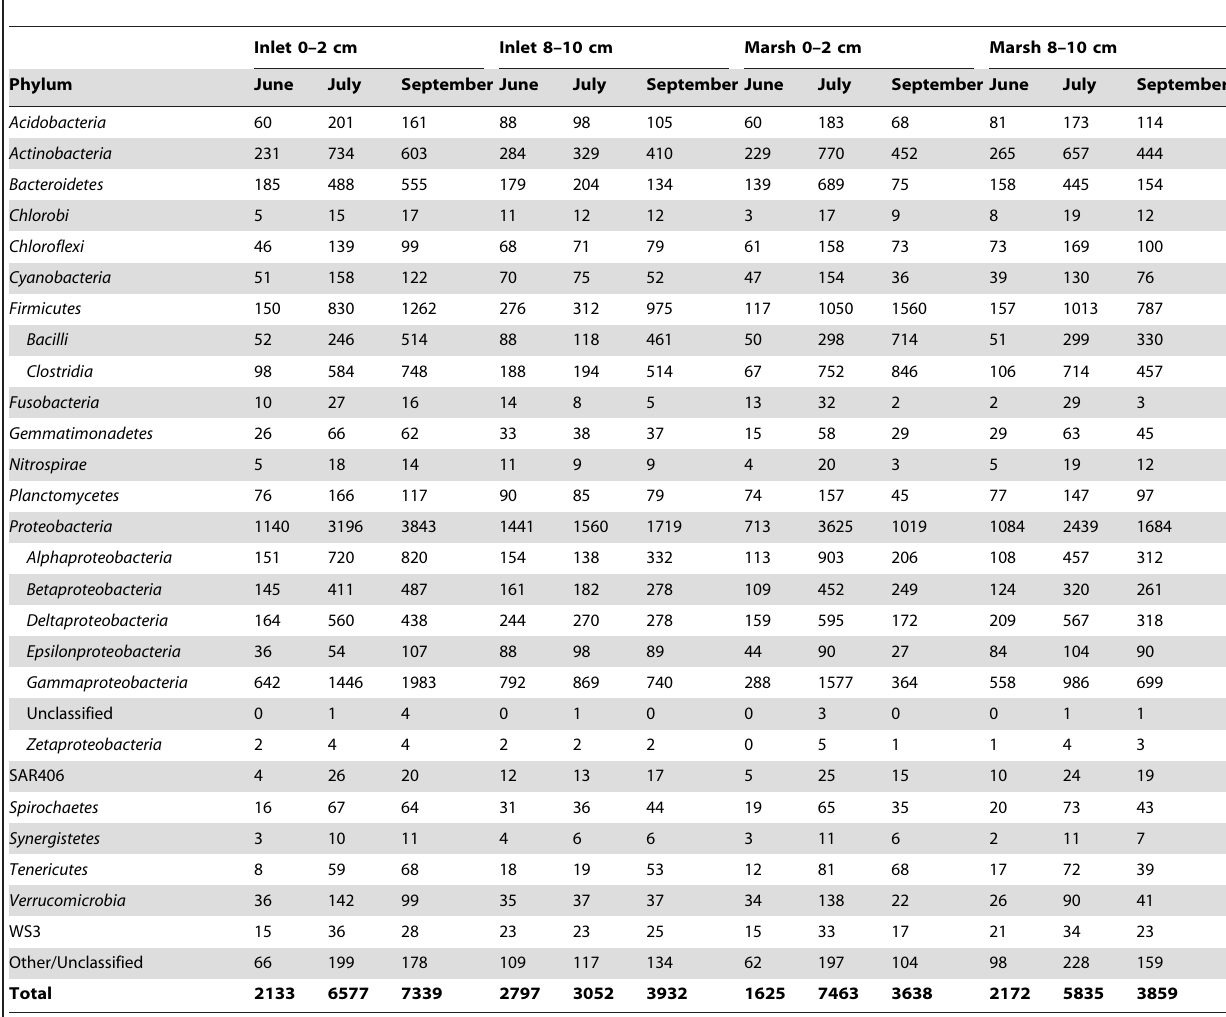
Table 3. Number of bacterial OTUs detected by PhyloChip in Inlet and Marsh sediments for June, July, and September